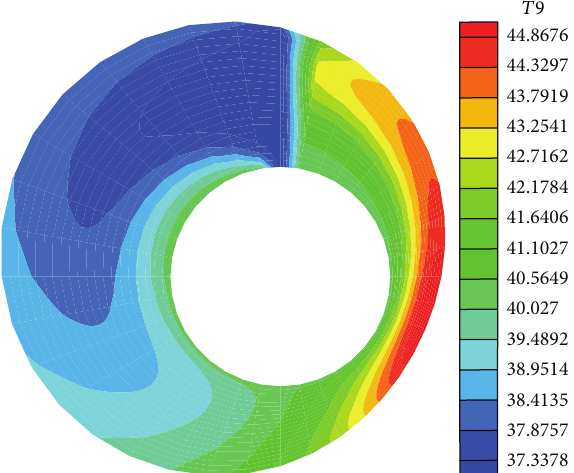
Figure 5: Isothermal lines of the journal bearing at its central plan for 𝑁 = 3000 rev./min and 𝑛 = 0.9 .